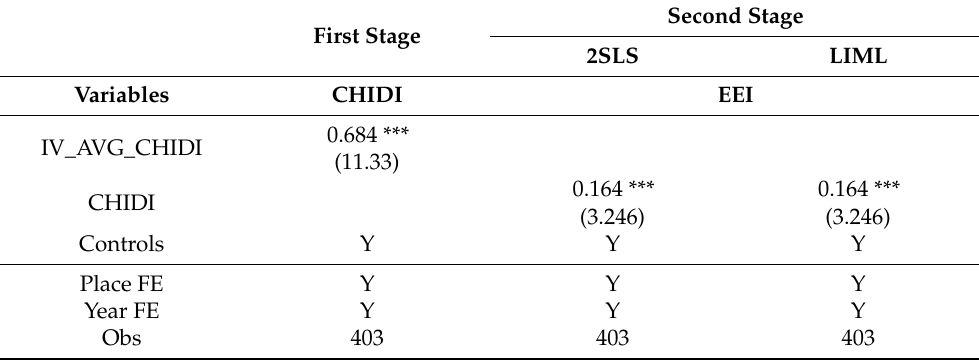
Table 6. IV Regression.